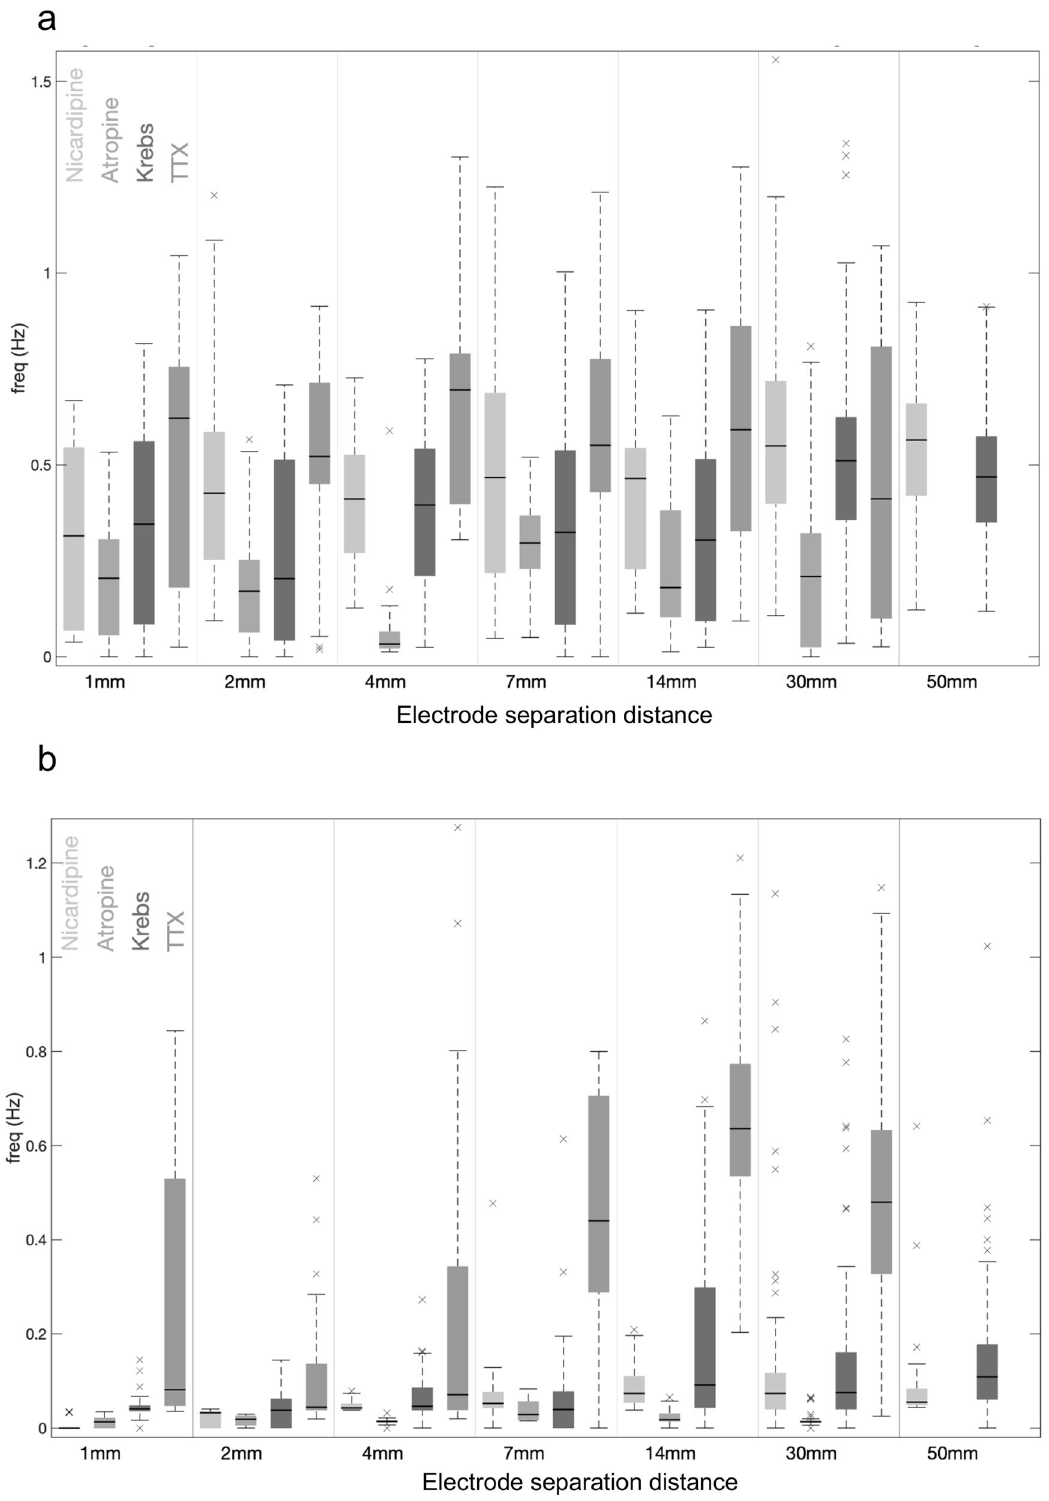
Fig. 6 Summary plots showing the difference in frequency of junction potentials between two recording sites recorded over increasing separation distances along the colon. Using a conventional boxplot, Plot a displays the distribution of the difference in frequency of junction potentials recorded prior to CMC electrical activity (measured between the proximal and distal colon). In TTX, there is a greater difference in frequency of junction potentials overall electrode separation distances. Plot b shows the frequency of junction potentials recorded from the proximal colon (i.e. frequency coordination) with junction potentials recorded more aborally, during periods of CMC electrical activity. In TTX, there is again a large difference in frequency of electrical activities overall electrode separation distances. The boxplots in a and b are conventional, where the horizontal dark line designates the median, the box edges the fi rst and third quartiles, and the whiskers extending up to 1.5 times the interquartile range. See Methodology for Wavelet Coherence and Frequency Coordination Analysis for precise analytical details and Supplementary Table 2 for t -tests comparing